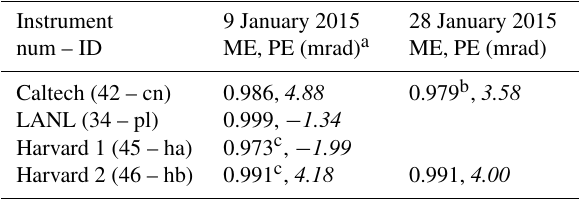
Table 2. ILS of EM27/SUN instruments.